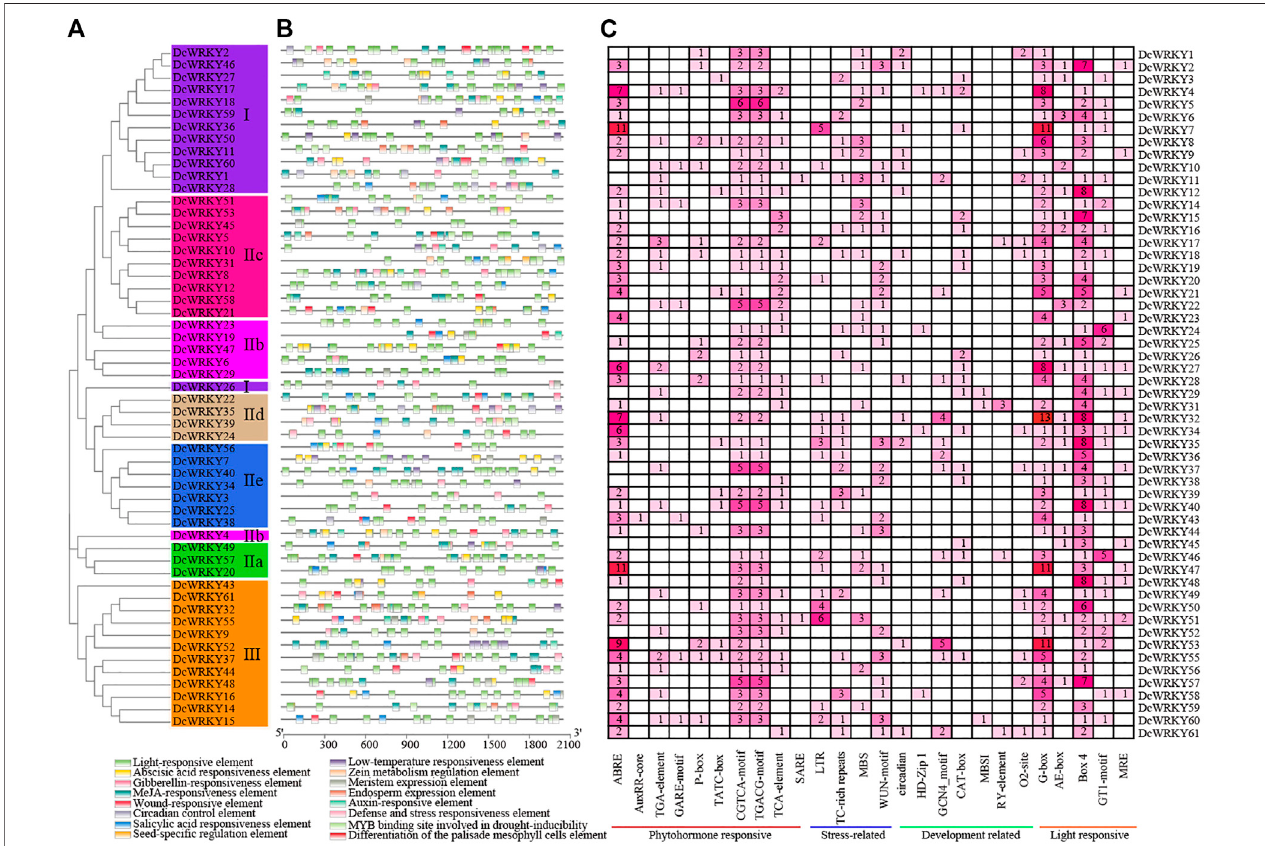
FIGURE 3 | Analysis of cis -elements in the DcWRKY genes promoter regions. (A) A phylogenetic tree of 62 DcWRKY proteins was constructed with the ML method.Thedifferentsubgroups areindicatedwithdifferentbackgroundcolorsand letters. (B) Thedifferentcoloredblocksrepresent thedifferenttypesof cis -elements and their locations in each DcWRKY gene. (C) The different colors and numbers in the grid indicate the numbers of different promoter elements in the DcWRKY genes. The types, numbers, and locations of potential elements in the promoter regions 2-kb upstream of the DcWRKY genes were analyzed by